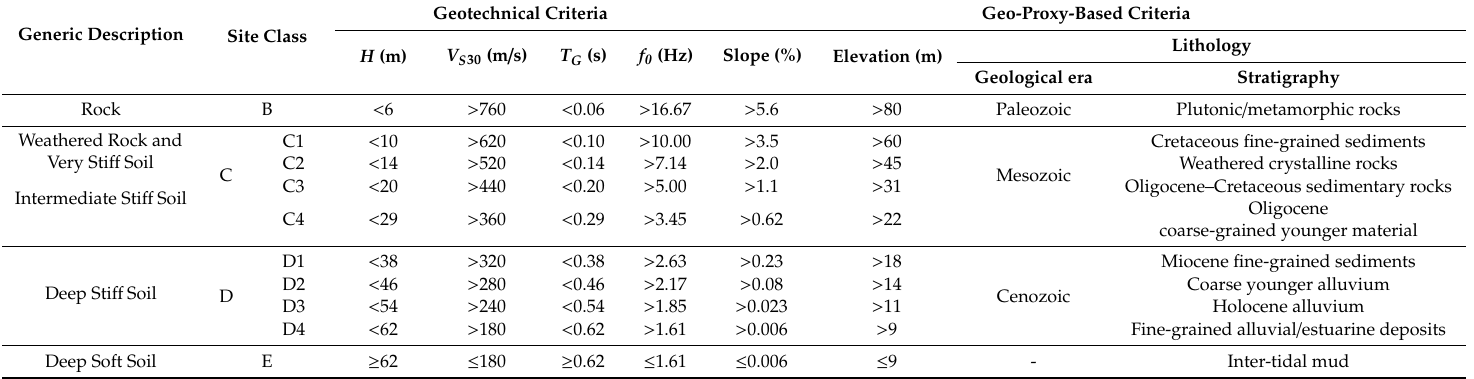
Table 1. Multivariate site classification system for seismic site e ff ects (modified after Kim et al.